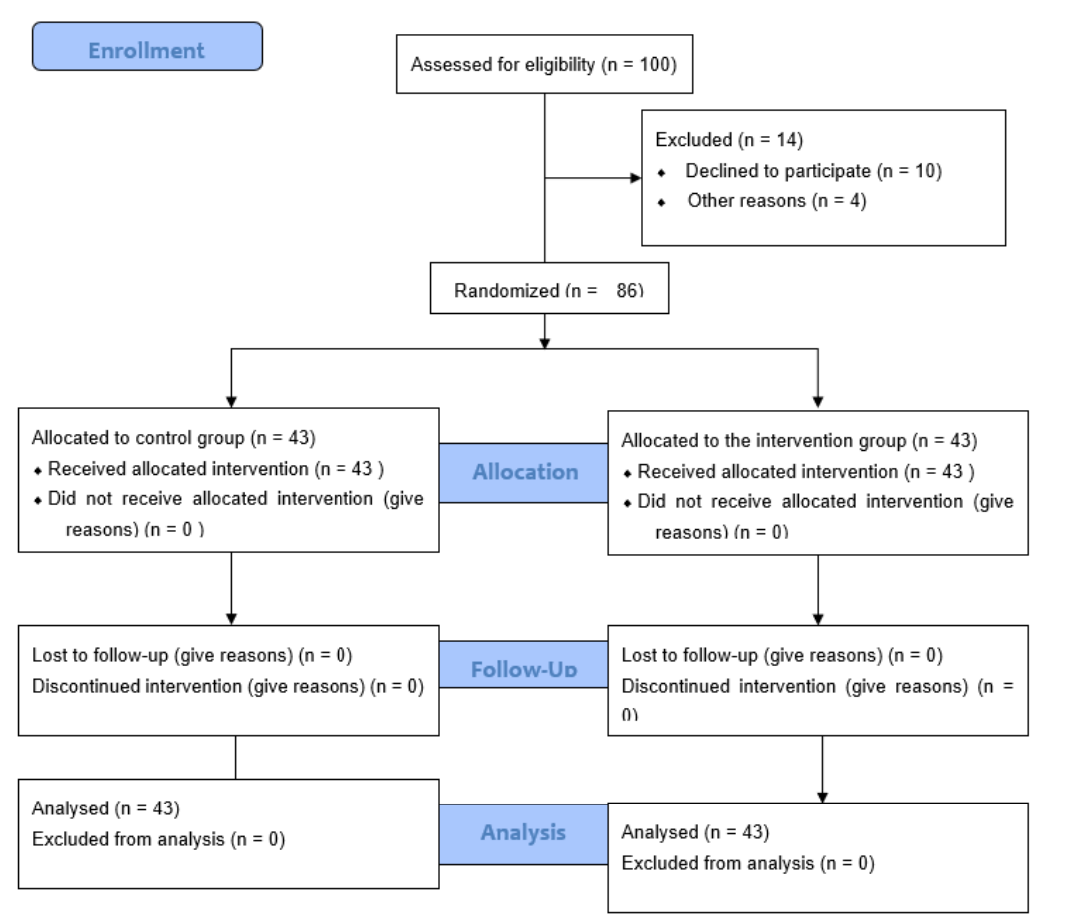
Figure 1. Flow diagram showing participants’ progress through the phases of the randomized two-arm parallel group clinical trial.